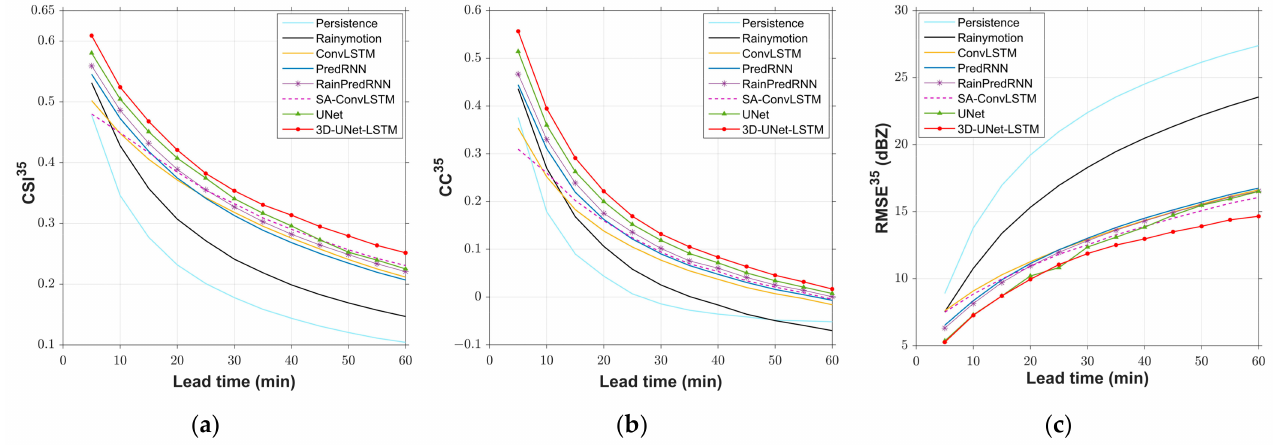
Figure 3. The ( a ) CSI , ( b ) CC and ( c ) RMSE curves produced by the eight models at the 35 dBZ threshold against different lead times. All values are the scores averaged over all cases in the test set at the corresponding lead